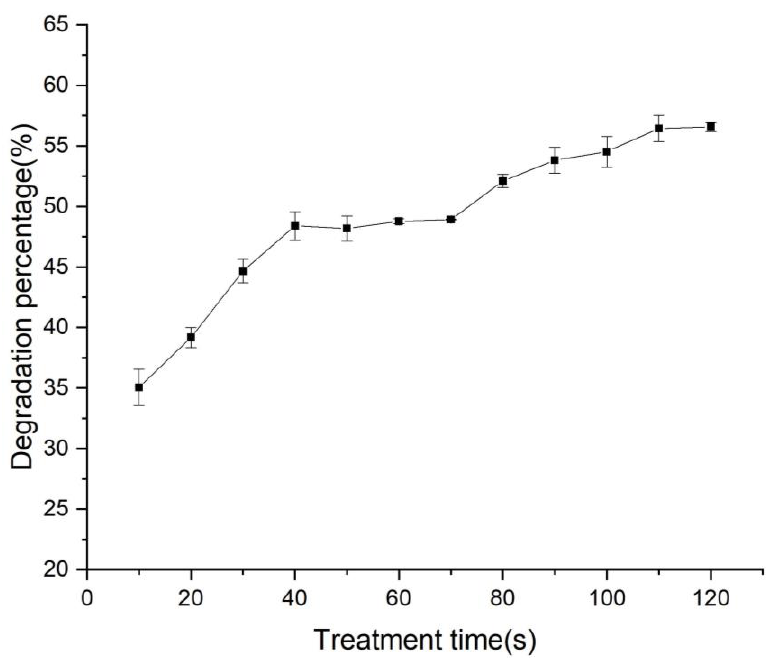
Figure 3. Degradation percentage of zearalenone treated at 50 KV.